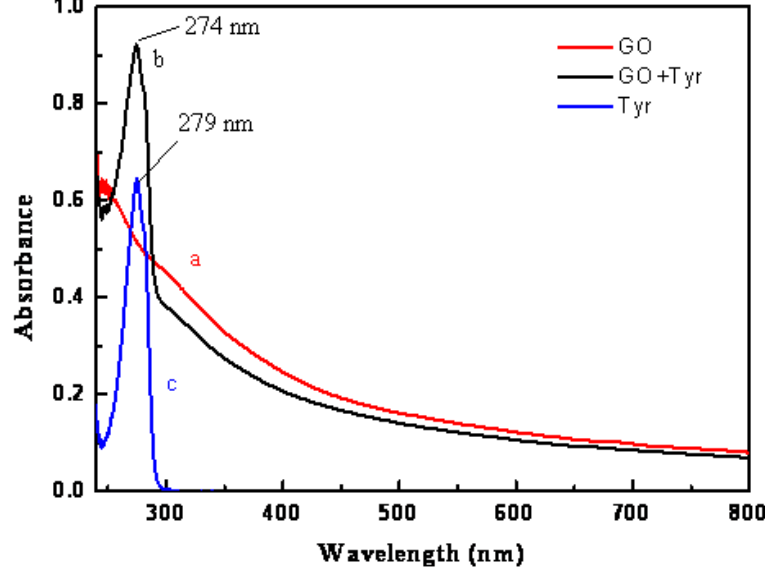
Figure 7. UV-visible absorption spectra for ( a ) GO; ( b ) GO in the presence of Tyr amino acid; and ( c ) Tyr amino acid.